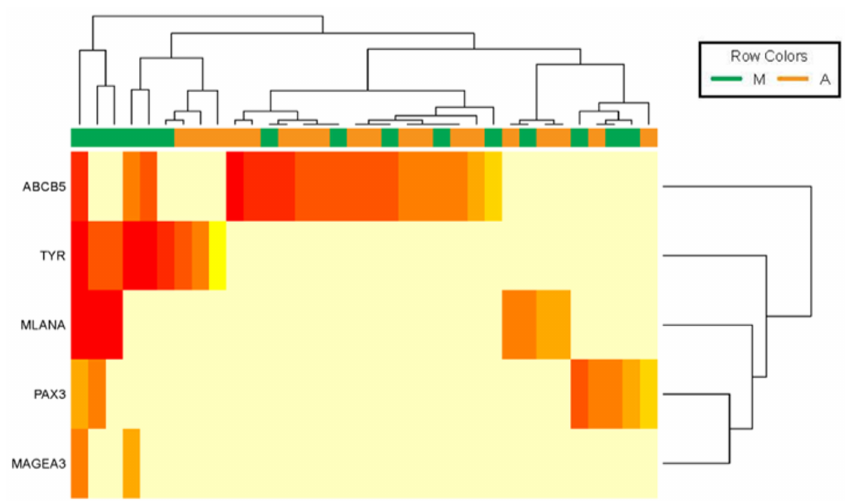
Figure 1. Heterogeneity in gene expression of MCSP- and ABCB5-enriched circulating tumour cell (CTC) fractions. Gene expression profiling of five melanoma-specific genes in CTC fractions enriched with MCSP- ( M ) and ABCB5- ( A ) coated beads that were positive for any transcript (25 out of 59 samples). Heatmap represents the expression levels of the melanoma-associated genes MLANA, TYR, MAGEA, ABCB5 , and PAX3 , which were assessed by qRT-PCR. All samples were positive for 18S rRNA (not shown), used as endogenous control. Each heatmap square corresponds to a Ct value for a target gene and a given sample; a higher tone of red indicates a higher gene expression and light yellow indicates no transcripts detected. Unsupervised hierarchical clustering demonstrates the inter- and intra- molecular heterogeneity of CTC